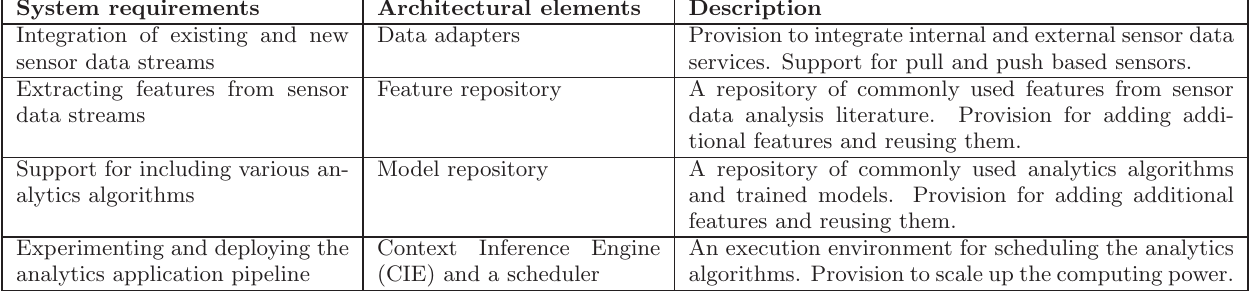
Table 2: List of system requirements for designing an analytics middleware and the corresponding system components.